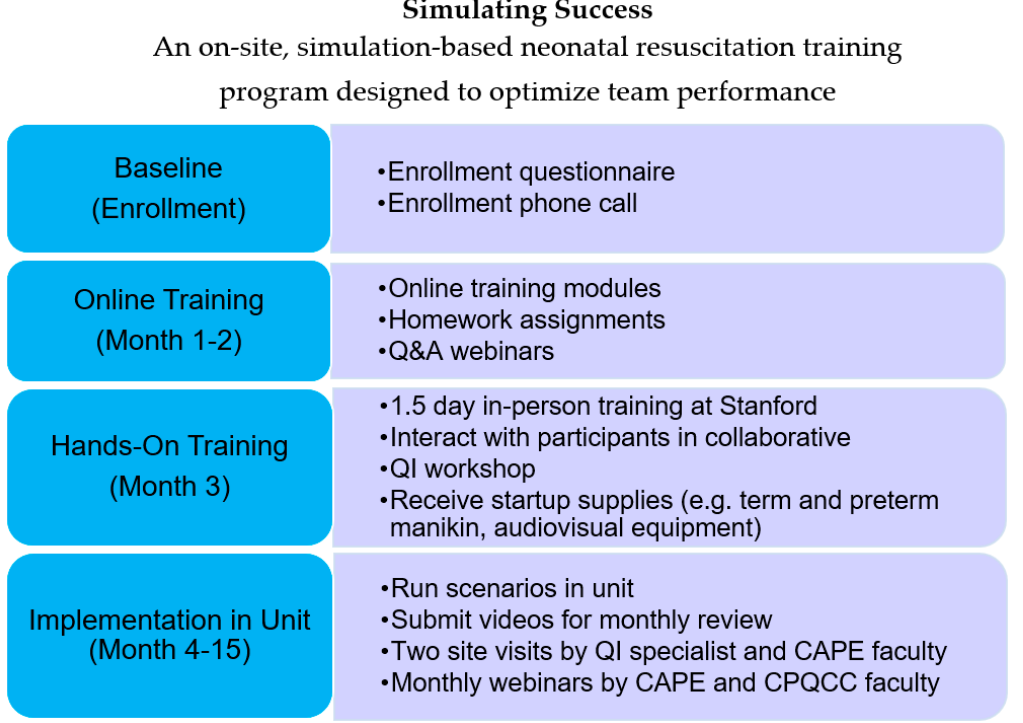
Figure 1. Simulating Success Project Timeline.